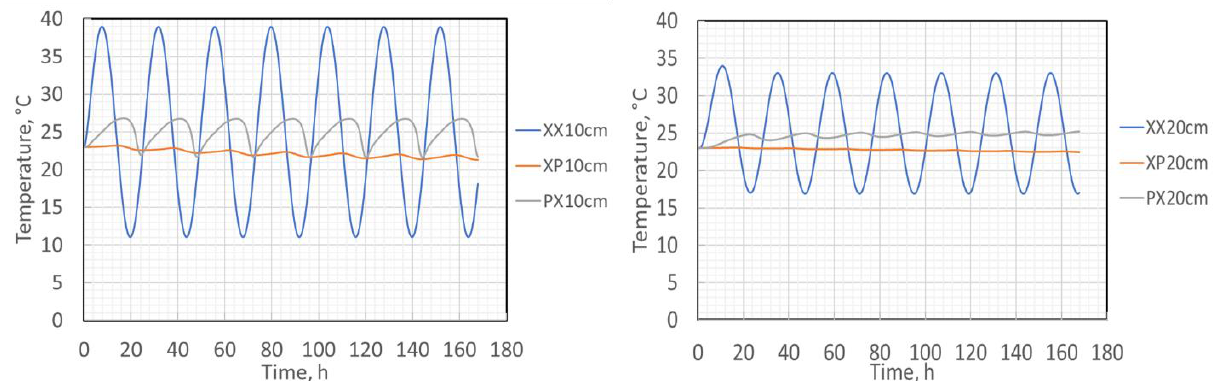
Figure 16. The internal surface temperature variation of a wall configuration of two layers. P stands for PCM; X stands for